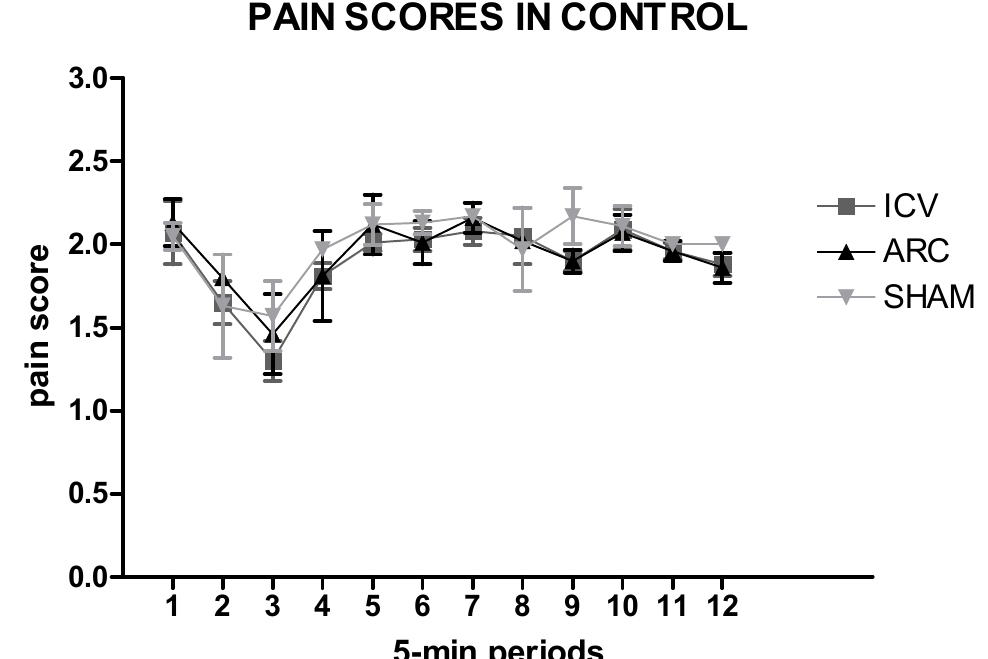
Figure 1. Time courses of the pain scores recorded in the control groups (Saline-lateral ventricle (ICV), Saline-ventromedial arcuate nucleus (ARC), SHAM) during the formalin test (60 min) divided into 5-min periods. Data are mean ± standard error of the mean (SEM).